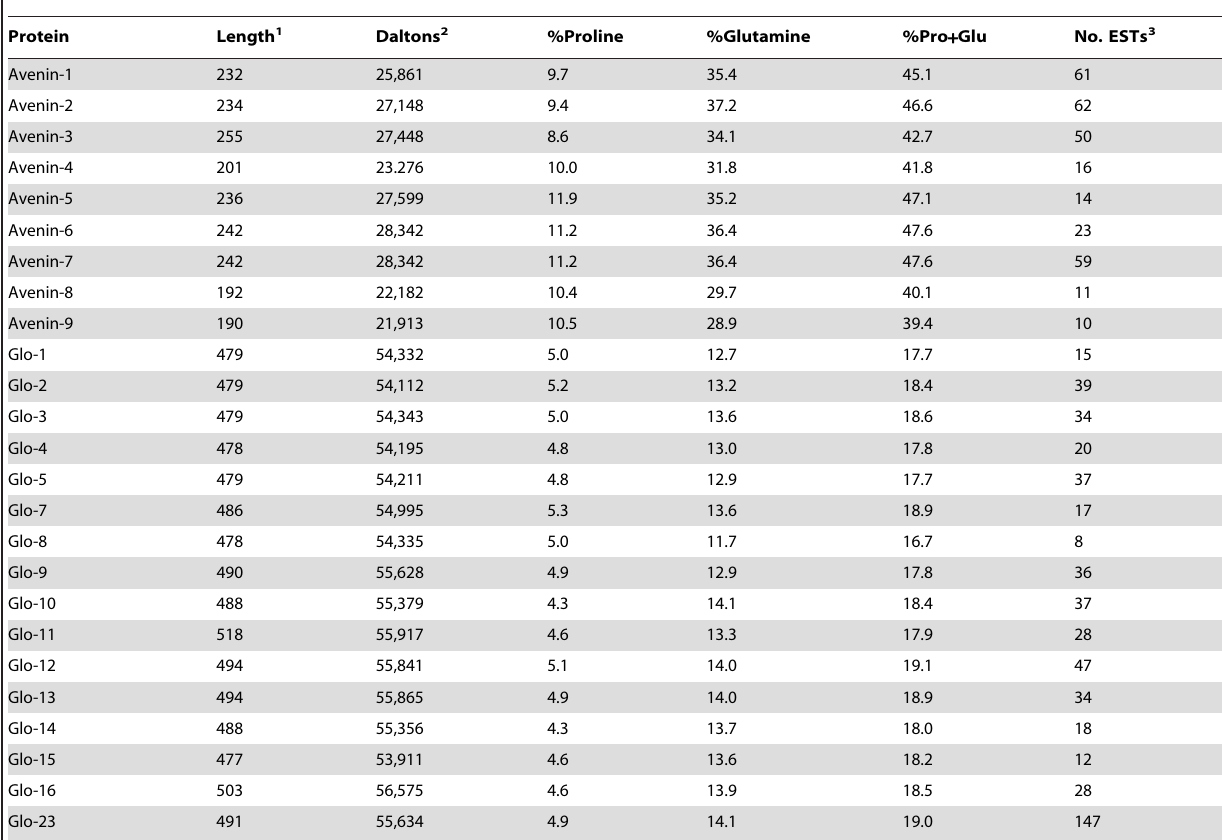
Table 1. Oat cv CDC Dancer avenin and globulin protein characteristics.